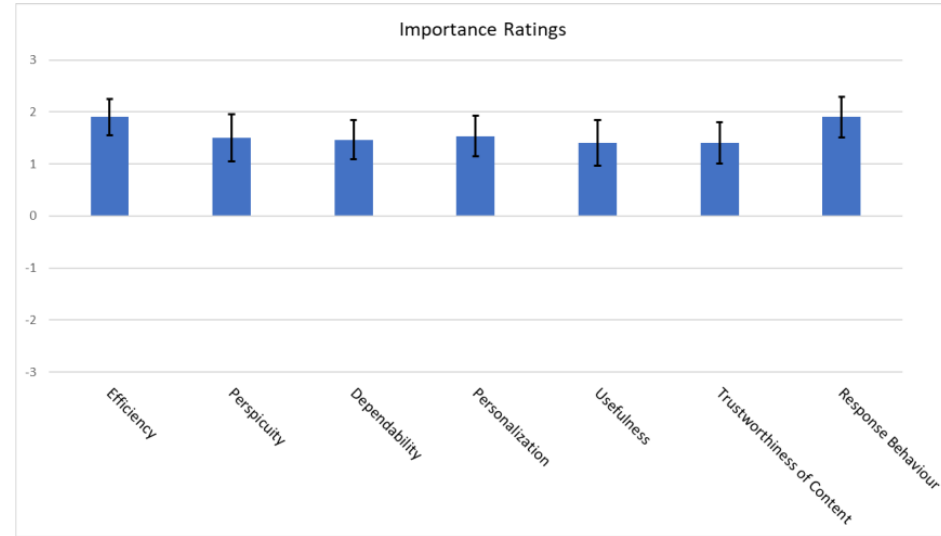
Figure 13. Importance ratings of scales.